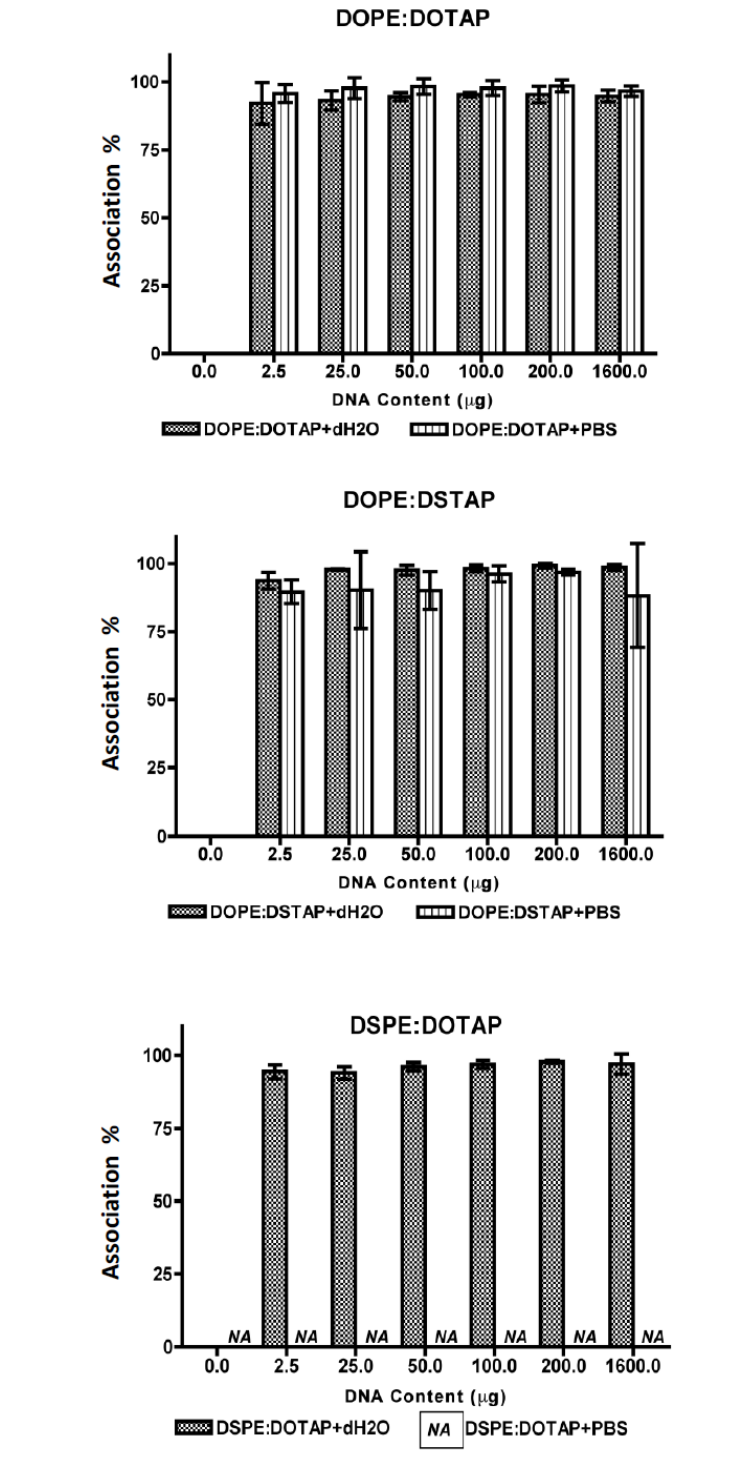
Figure 3. DNA association within lipoplexes of DOPE:DOTAP, DOPE:DSTAP, DSPE:DOTAP in distilled water and PBS and in various concentrations of DNA. Results denote mean ± SD, n =